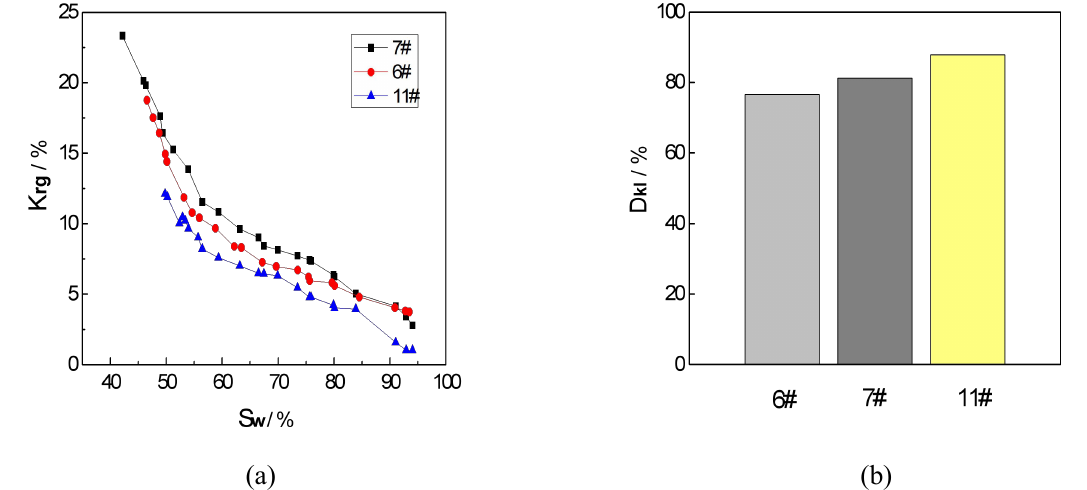
Figure 4—Result for #6, #7, #11. (a) Curves of relative gas permeability. (b) WBI.